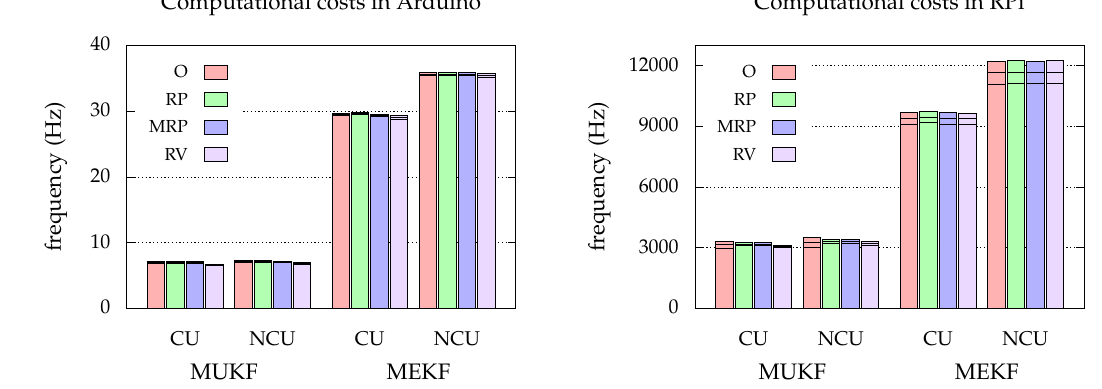
Figure 4. Maximum update frequency for each approach. The lines at the top represent the mean and the deviation (3 σ ) of the distribution of maximum update frequencies. “CU” stands for Chart Update, while “NCU” stands for No Chart Update.